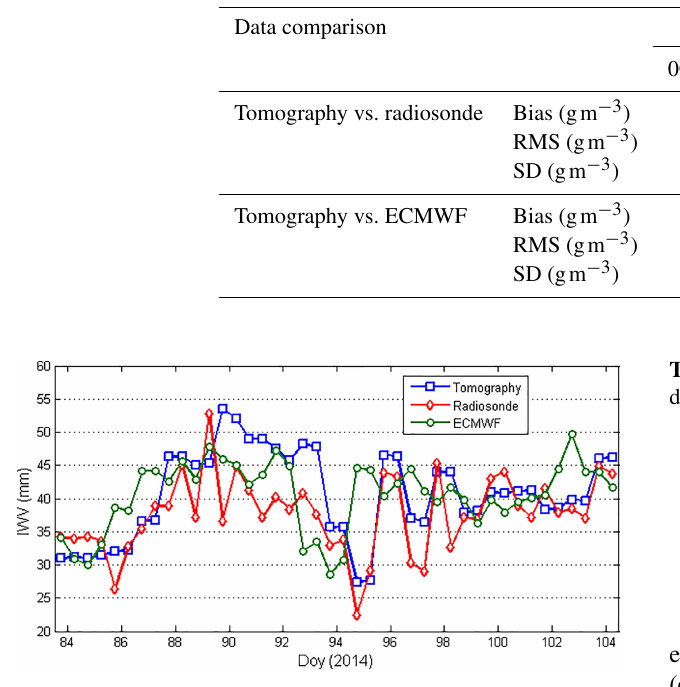
Figure 8. Comparison of IWV time series derived from radiosonde, ECMWF, and tomography modeling for Scheme 4. Table 3. Statistical results of integrated water vapor (IWV) between radiosonde, ECMWF, and tomography for Scheme 4 (unit: mm).